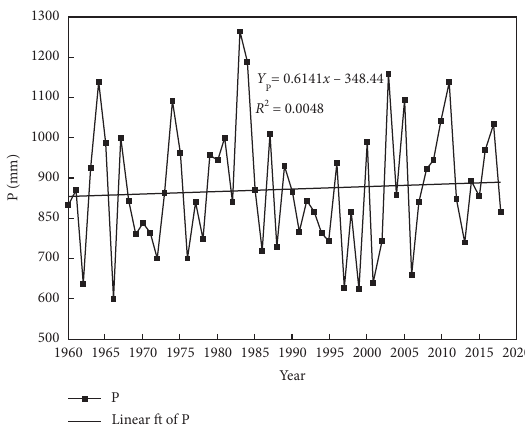
Figure 4: The variation in precipitation in the Yue River watershed during 1960–2018.